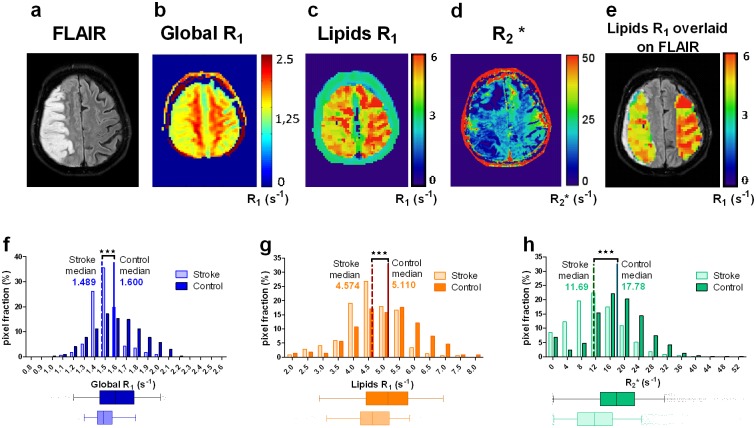
Full display of morphological/quantitative data sets obtained in a patient.Axial transverse FLAIR image (1.a) through centrum semiovale showing hyperintensity within acutely infarcted whole territory of the right middle cerebral artery (MCA), and corresponding global R1-mapped image (1.b), lipids R1-mapped image (MOBILE) (1.c) and R2*-mapped image (1.d) in a similar slice location. Image 1.e: overlay of the two ROIs (right-sided contour of infarction and left-sided mirrored one) from the MOBILE map (1.b) on the FLAIR image (1.a). Images 1b-1e have been smoothed using the ‘Gaussian Blur’ function (radius of 2 pixels) of the GIMP software (GIMP 2, GNU Image Manipulation Program, GPLv3). Histograms of global R1 (1.f), lipids R1 (1.g) and R2* (1.h) of the same patient demonstrating significant shift of the medians to lower values for the stroke area. Differences of 0.111 s-1, 0.536 s-1 and 6.09 s-1 are observed for global R1, lipids R1 and R2*, respectively.